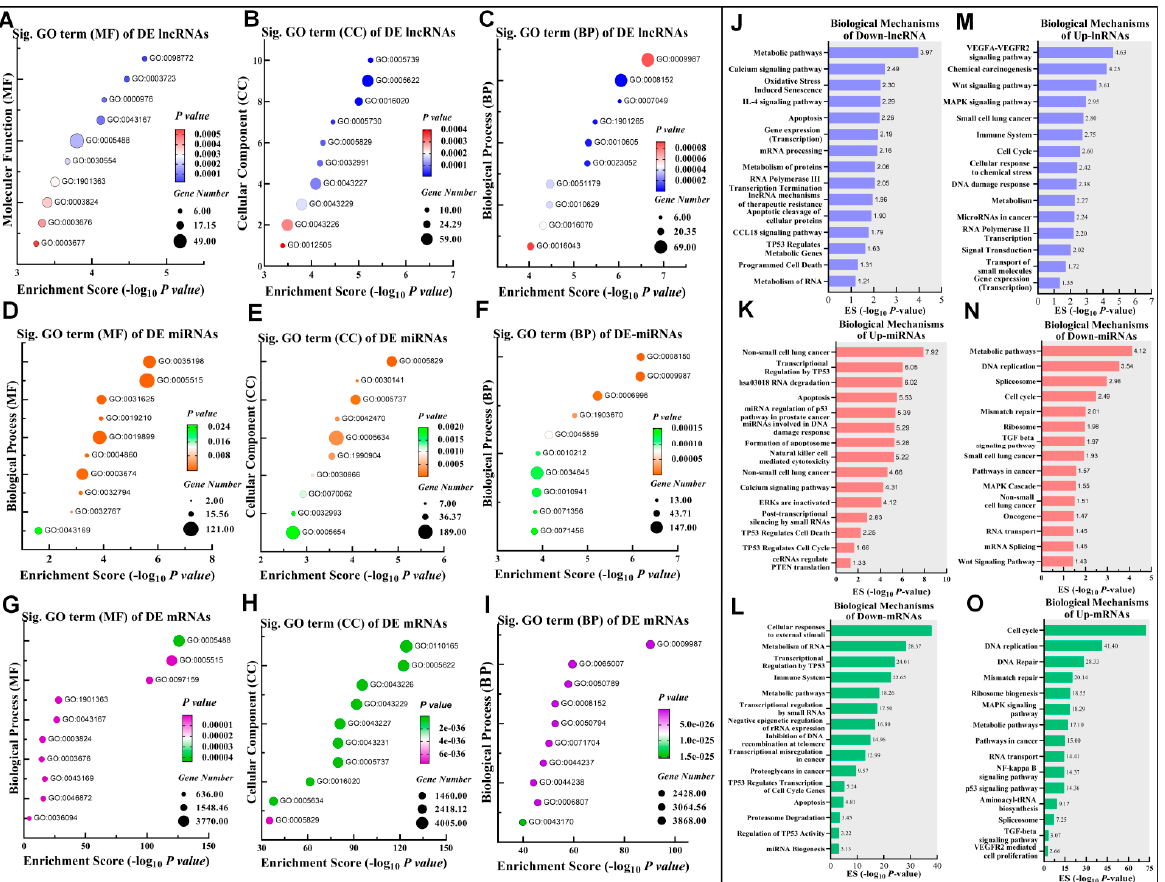
Figure 2. Biological profiles of DE lncRNA, miRNA, and mRNA transcripts. ( A ) Top significant GO terms of linked MF DE lncRNA profile. ( B ) Top significant CC. ( C ) Top significant BP of DE lncRNA profile. ( D – F ) Top significant MF, CC, and BP from the DE miRNAs, respectively. The top significant terms of MF, CC, and BP from the DE mRNAs are represented in ( G – I ), respectively. The top significant biological pathways of down-lncRNA, up-miRNA, and down-mRNA (tumor suppressor axis) are shown in ( J – L ). The significant biological pathways of the oncogenic axis of Up- lncRNA, Down-miRNA, and Up-mRNA are represented in ( M – O ). The dot size reflects the number of shared genes in each biological function and the dot two-color system indicates the p -values. The DE RNAs are categorized into up-lncRNA/down-miRNA/up-mRNA as an onco- genic axis and down-lncRNA/up-miRNA/down-mRNA as a tumor suppressor regulatory axis. The biological mechanisms were enriched based on the Kyoto Encyclopedia of Genes and Genomes (KEGG), Reactome (REAC), and Wiki (WP) pathways. The most enriched pathways to the tumor suppressor axis were linked mainly with apoptosis, TP53